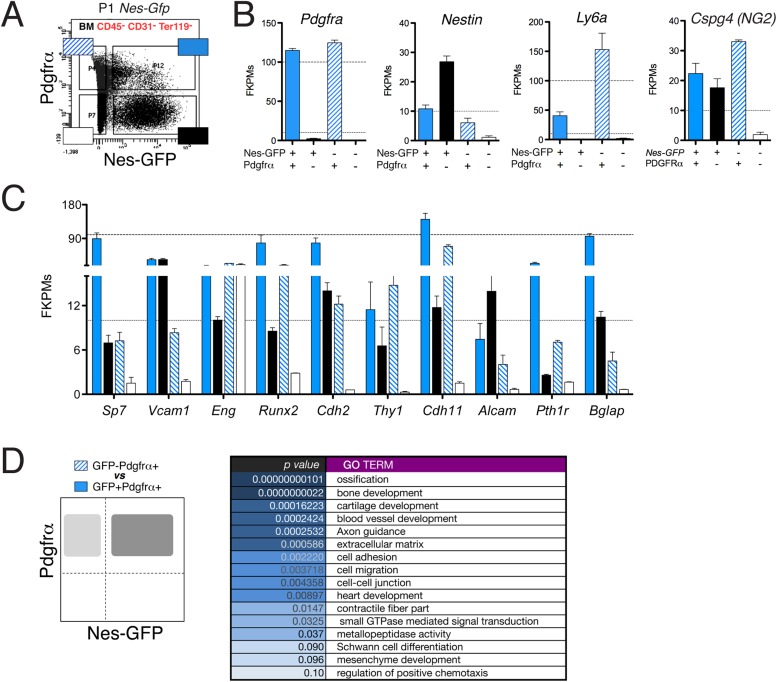
The neonatal Nes-GFP+ bone marrow population is enriched in primitive mesenchymal progenitors.(A) Representative FACS profile of GFP and Pdgfrα expression in CD45− CD31− Ter119− BMSCs from neonatal Nes-Gfp long bones. Four different stromal subpopulations identified based on expression levels of Pdgfrα and GFP were isolated and analyzed by RNAseq. (B) Endogenous transcript expression levels of Nestin, Pdgfra, Cspg4 (NG2), and Sca1 (Ly6a) in isolated stromal populations depicted in (A), expressed in fragments per kilobase of exon per million fragments mapped (FPKM). (C) Expression profiles of characteristic mesenchymal genes in the stromal subpopulations. (D) Functional gene ontology enrichment analysis (DAVID software) of genes differentially expressed (p ≤ 0.10) between the GFP+ and GFP− subsets of P1 Pdgfrα+ bone marrow stromal cells.